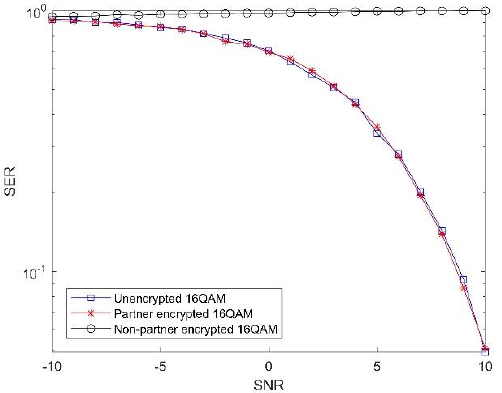
Figure 11. Simulation diagram of the bit error rate of 16QAM scrambling constellation encryption algorithm.